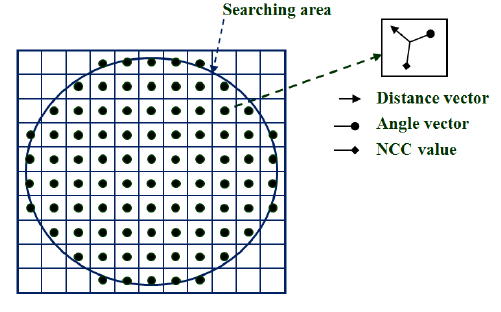
Figure 11. Illustration of the sample point description for